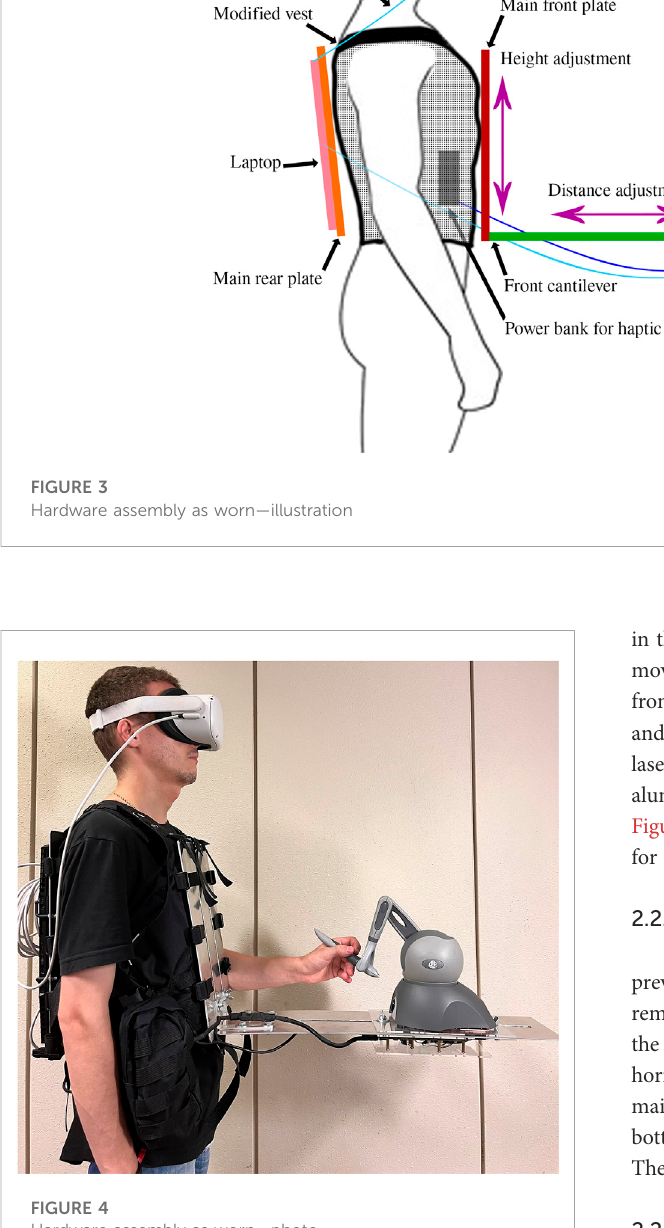
FIGURE 4 Hardware assembly as worn —